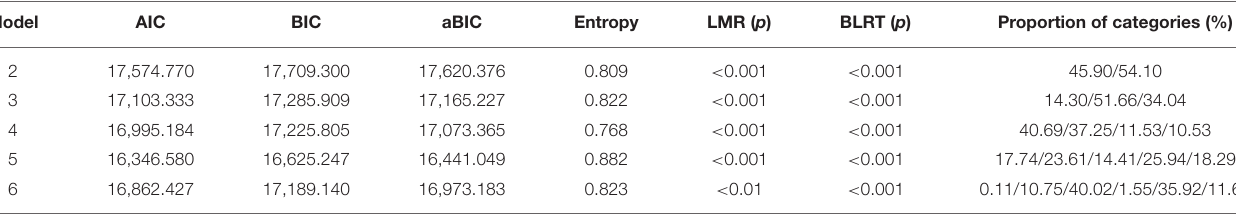
TABLE 3 | The results of latent profile analysis of positive solitude.